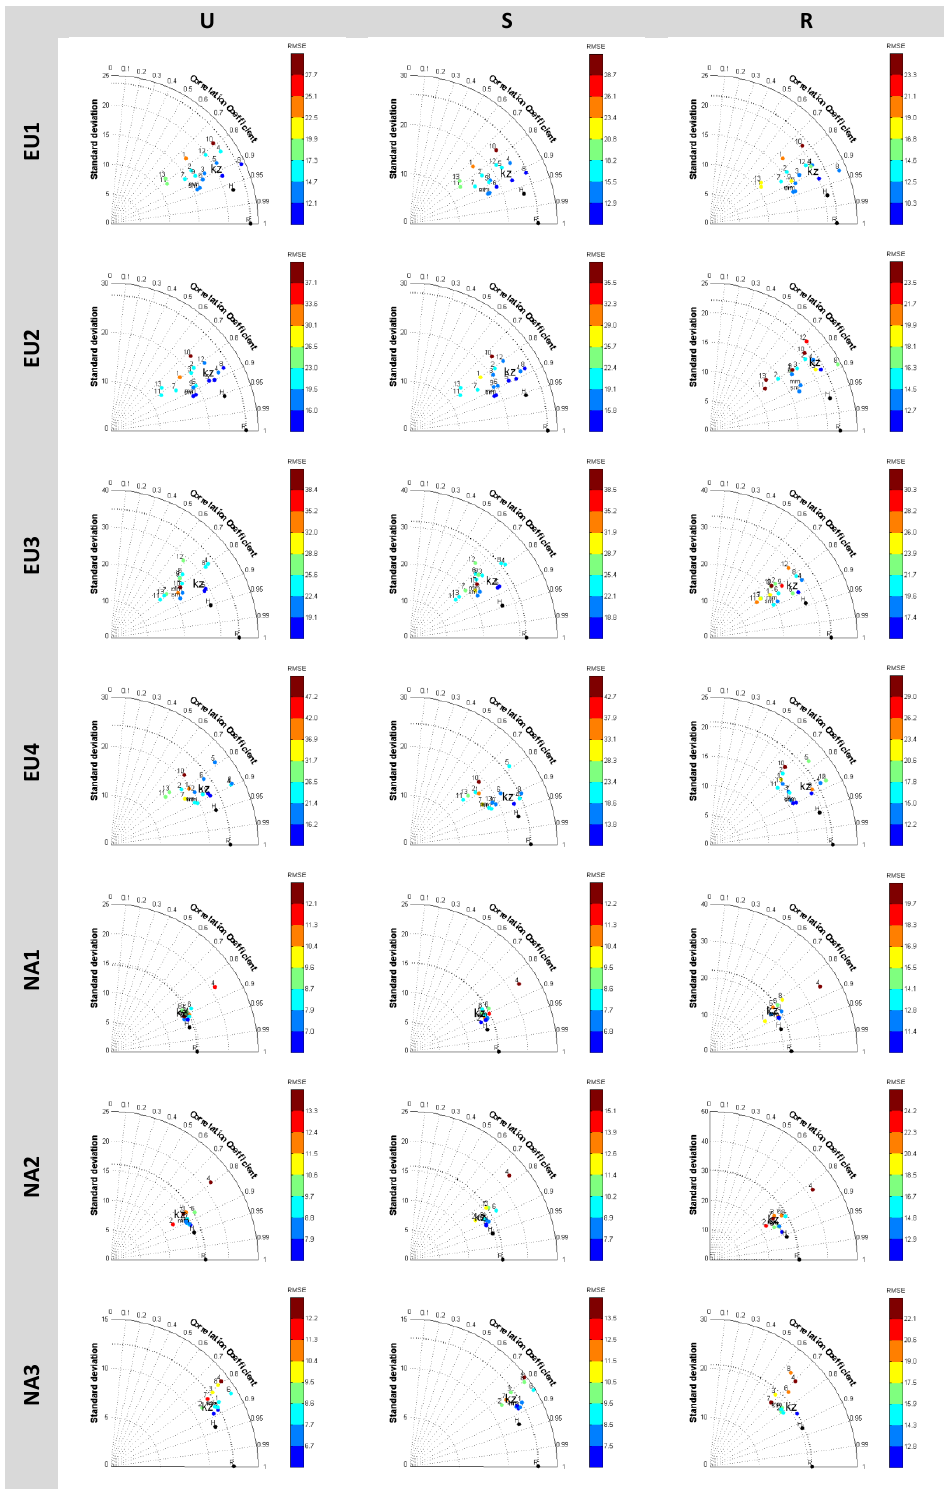
Fig. 9a. Summary statistics of all examined cases corresponding to the prediction week, for all seven subdomains and three ozone aggre- gation types. (a) Taylor diagrams: despite the different deterministic model excelling at each sub-domain, the behaviour of the kz model is homogeneous across domains achieving the least RMSE, very high PCC and STD close to the observed